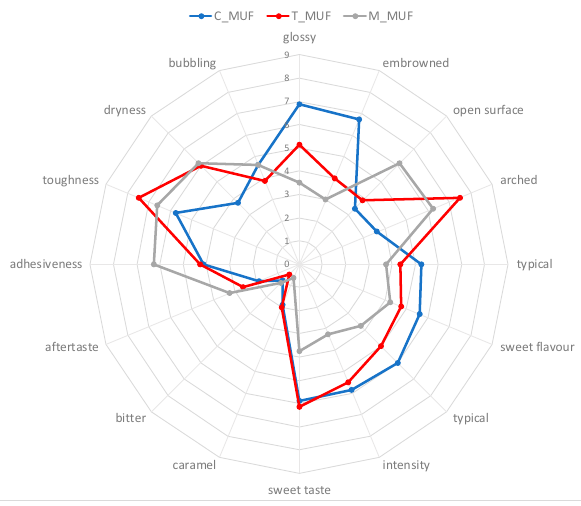
Figure 9. Sensory profile of C_MUF, M_MUF and T_MUF muffin samples. C_MUF = Muffin prepared by C_BP; M_MUF = Muffin prepared by M_BP; T_MUF = Muffin prepared by T_BP. 0-9 = Judge scores from 10-point structured scale.